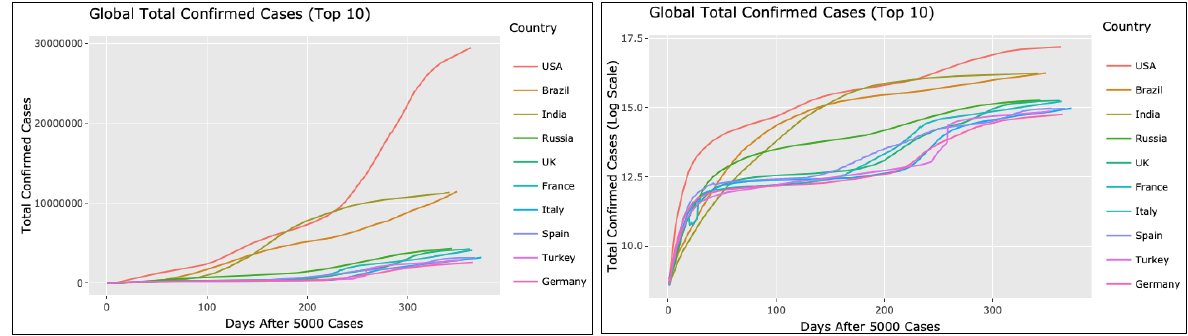
Figure 7. Before (Left) and After (Right) Log Transformation